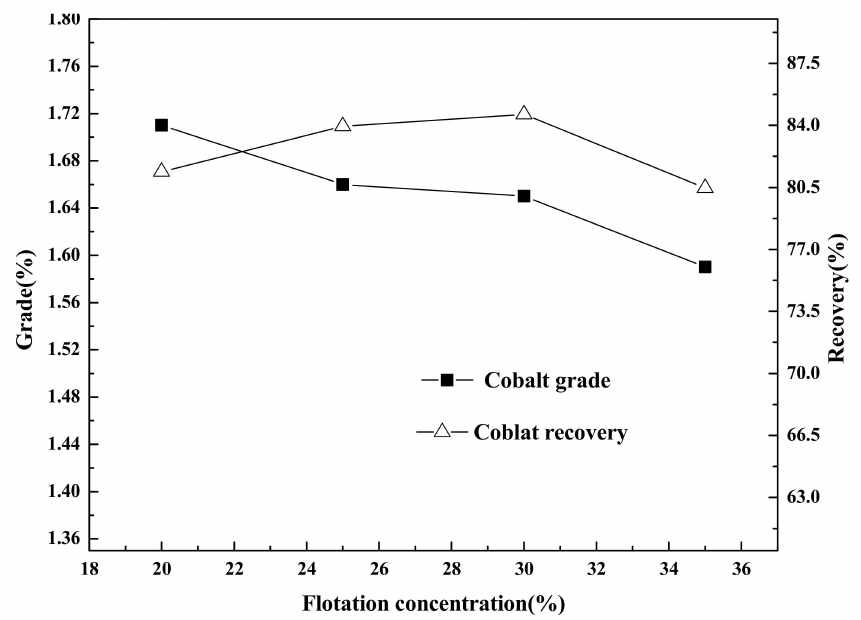
Figure 7. E ff ect of flotation concentration on cobalt grade and recovery in